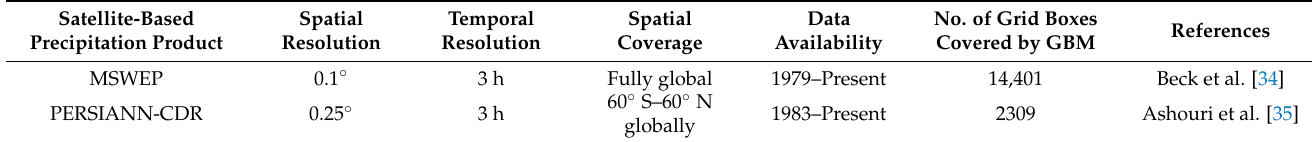
Table 1. Summary of satellite-based precipitation product used in this work.